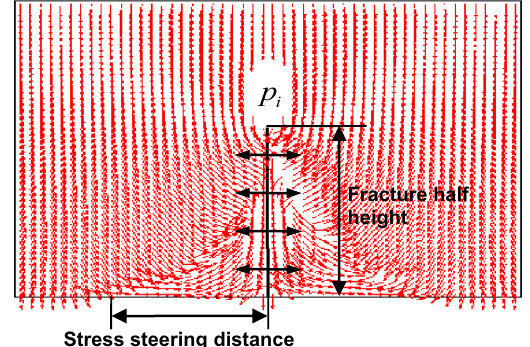
Fig. 6 The schematic diagram for defining the stress steering distance by the change of the direction of the maximum horizontal principal stress in induced stress